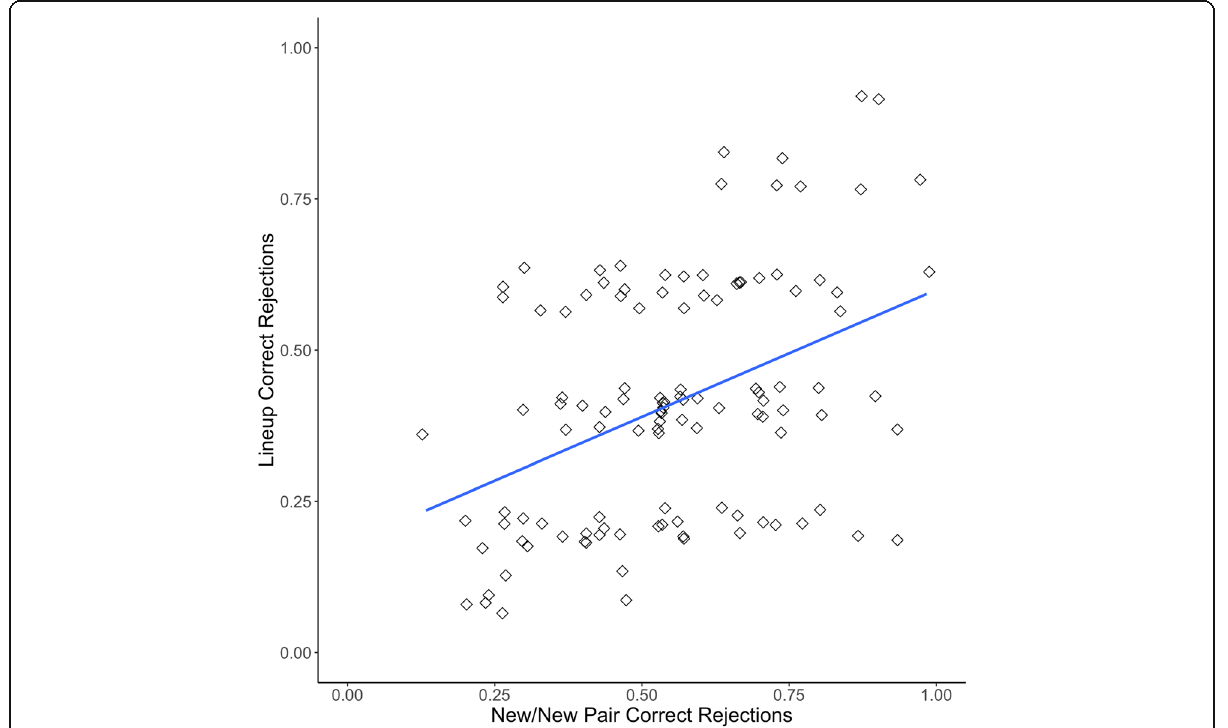
Fig. 4 Proclivity to choose correlation for Experiment 2 with linear trendline, both axes